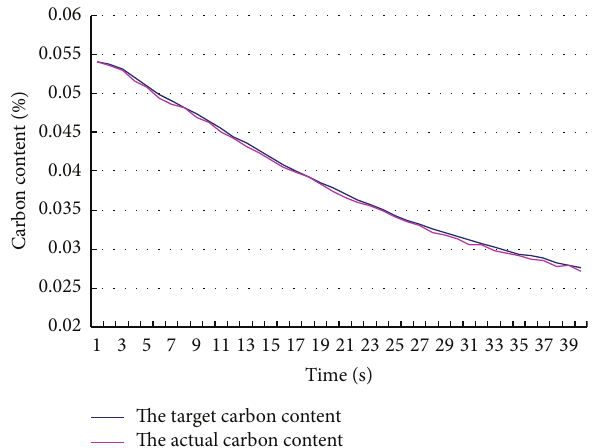
Figure 5: Dynamic curves between the actual carbon content and the target carbon content.